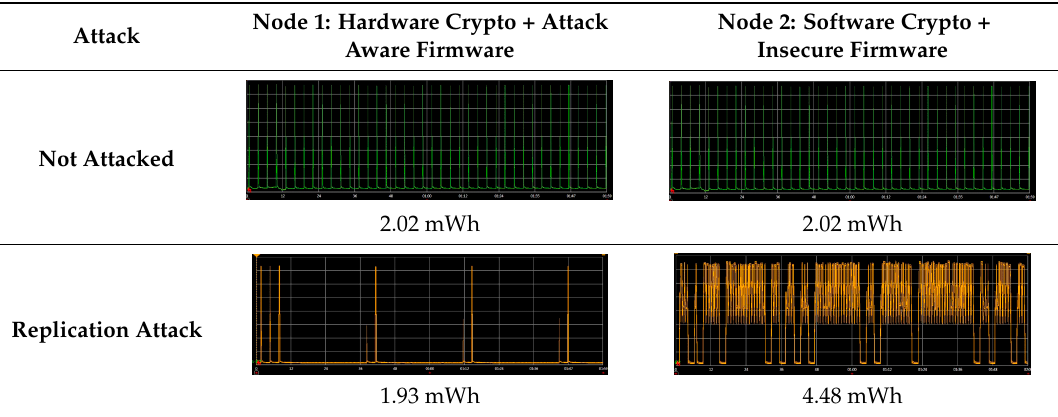
Table 7. Energy Consumption results.